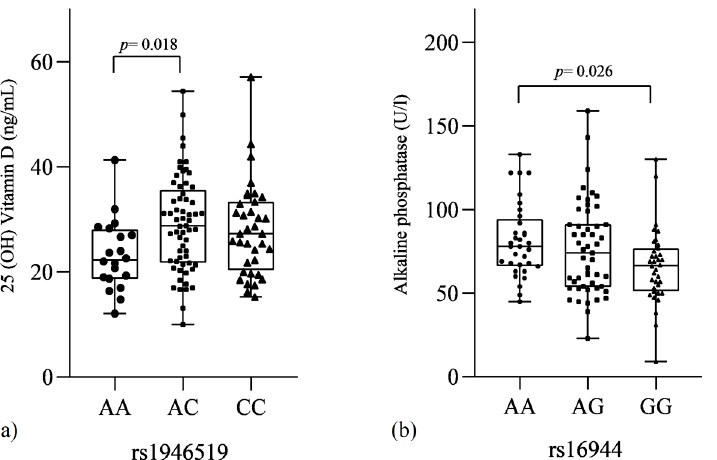
Figure 3. Comparison of biochemical markers of bone homeostasis in serum according to genotypes of single ‐ nucleotide variants rs1946519 of IL ‐ 18 and rs1644 of IL ‐ 1 β gene. ( a ) Comparison of 25(OH) Vitamin D levels between genotypes of rs1946519 of IL ‐ 18. ( b ) Comparison of Alkaline phosphatase levels between genotypes of rs16944 of IL ‐ 1 β . Statistical tests values: ( a ) p ‐ value ANOVA = 0.029; p ‐ value Tukey = 0.018 (AA vs. AC); ( b ) p ‐ value ANOVA/Kruskall–Wallis = 0.023; p ‐ value Dunn’s test = 0.026 (AA vs. GG).